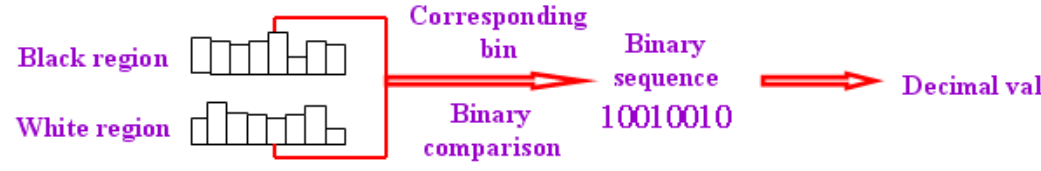
Figure 9. The local feature extraction and encoding.